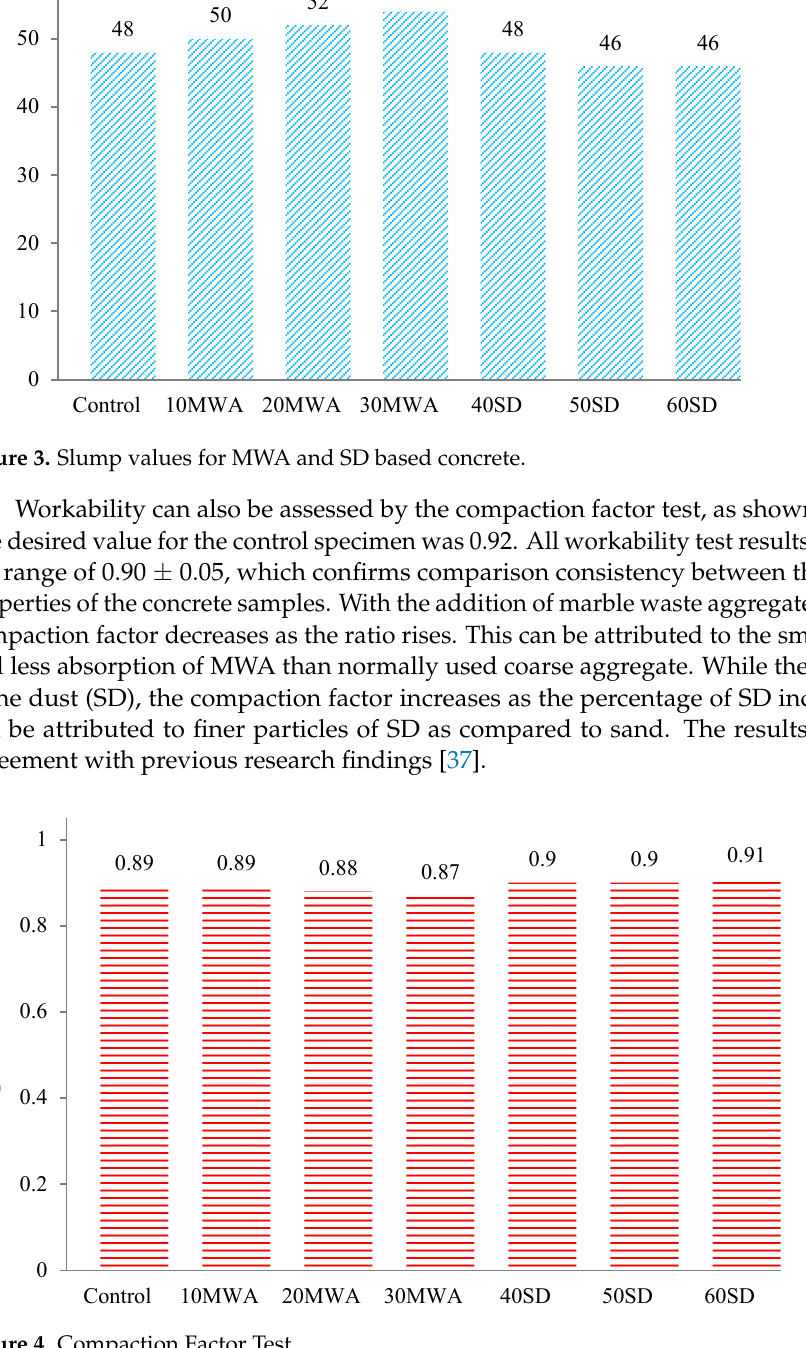
Figure 4. Compaction Factor Test .